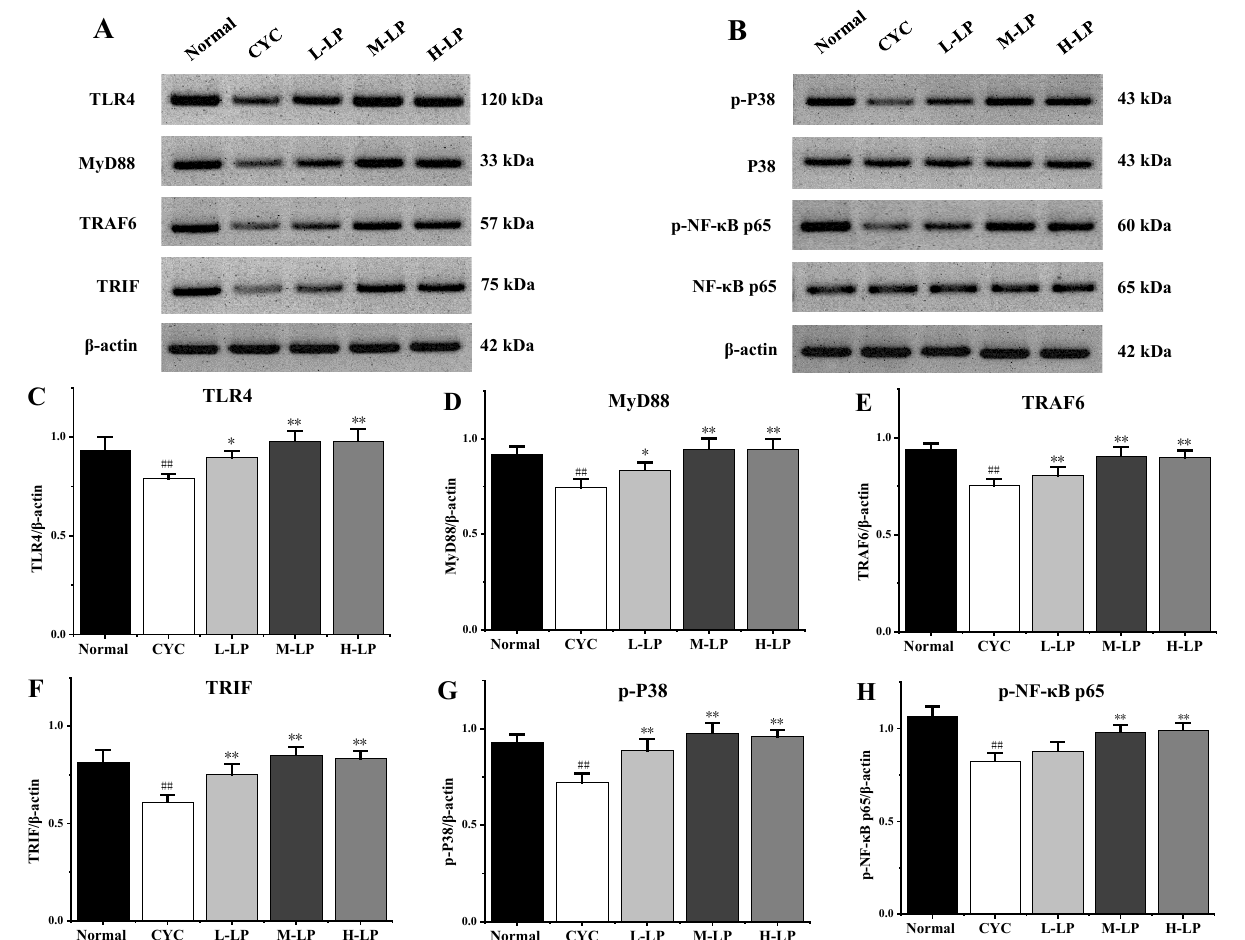
Figure 3. Effects of LP on the key proteins in small intestine of mice. ( A ) Western blot bands of TLR4, MyD88, TRAF6, and TRIF. ( B ) Western blot bands of p -P38, P38, p -NF- κ B p65, and NF- κ B p65. ( C – H ) Quantitative analysis of TLR4, MyD88, TRAF6, TRIF, p -P38, and p -NF- κ B p65, respectively. Note: n = 3, ## p < 0.01 vs. Normal group, * p < 0.05, ** p < 0.01 vs. CYC group.